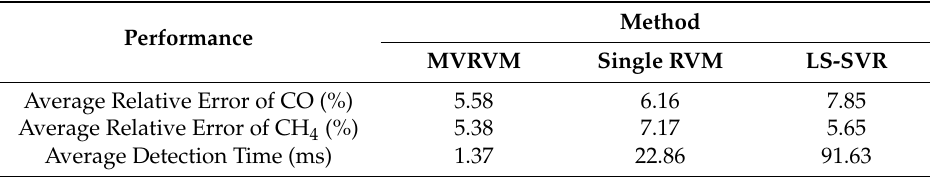
Table 5. Comparison of binary mixed gas concentration detection